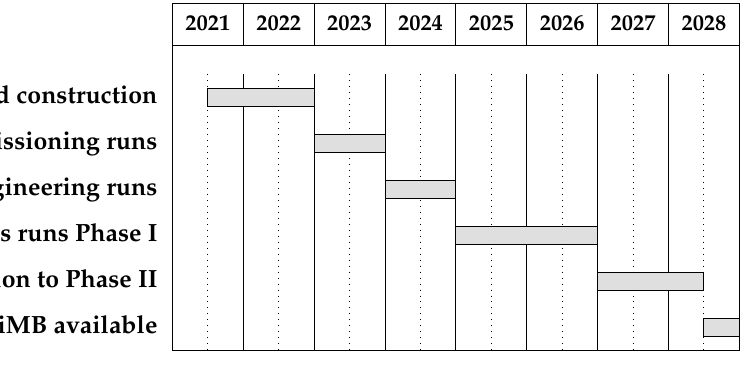
Table 4. Simplified operations schedule of the Mu3e